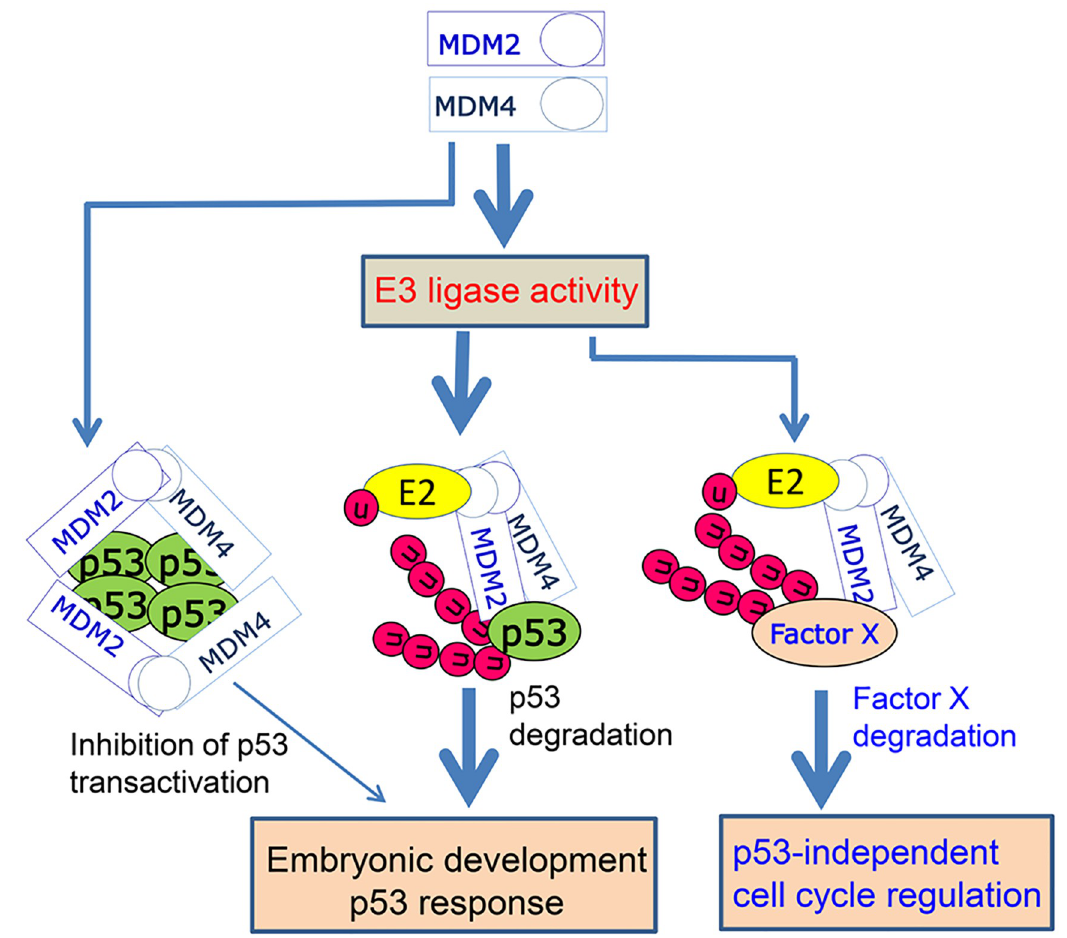
Fig 7. A model for the role of MDM2-MDM4 heterodimers in regulation of p53 and cell cycle. MDM2-MDM4 heterodimer mediated p53 ubiquitination and proteasomal degradation is essential for restricting p53 activity during embryonic development and for a rapid and robust p53 checkpoint response. Inhibition of p53 transactivation by MDM2-MDM4 heterodimers plays a marginal role in these processes. MDM2 E3 ligase activity is required for p53-independent cell cycle regulation via uncharacterized mechanisms involving Factor X degradation. Thick arrow, strong effect, thin arrow, marginal